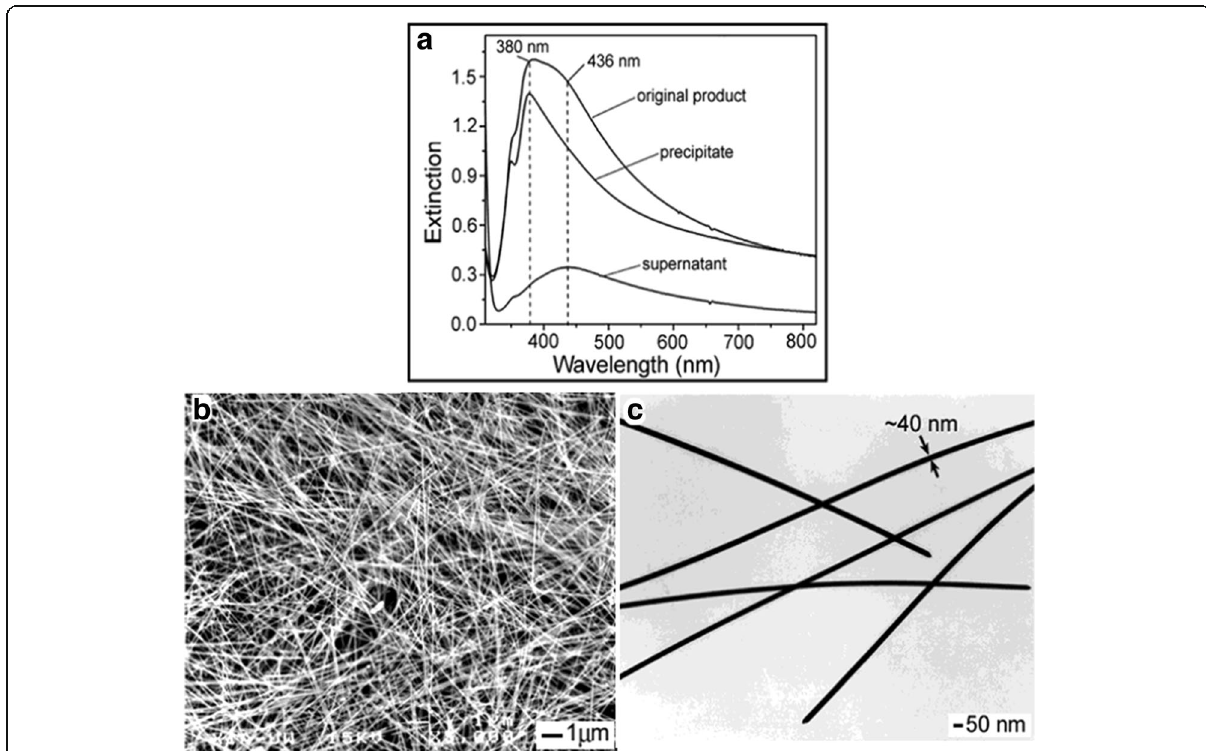
Fig. 3 a UV-visible extinction spectra of the final product before and after 3 cycles of centrifugation and separation. b SEM and c TEM images of a purified sample of silver nanowires